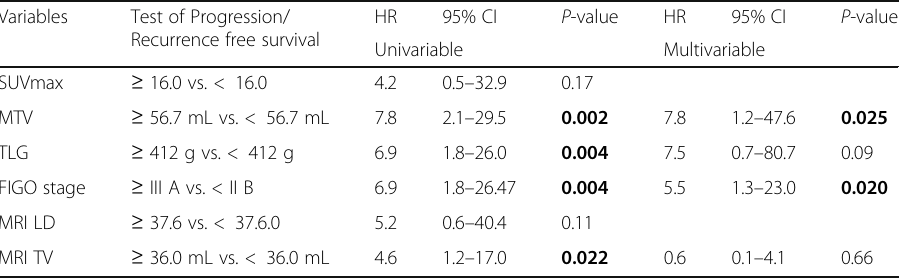
Table 4 Univariable and multivariable cox-regression analyses for PET-CT and MRI parameters and FIGO stage for predicting progression/recurrence free survival in cervical cancer patients Variables Test of Progression/ HR 95% CI P -value Recurrence free survival